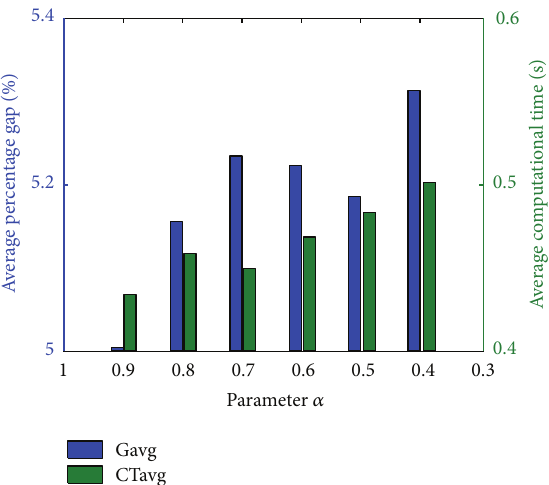
Figure 5: The effect of the value of population size 𝑝𝑠 with respect to relative computational time and average percentage gap.